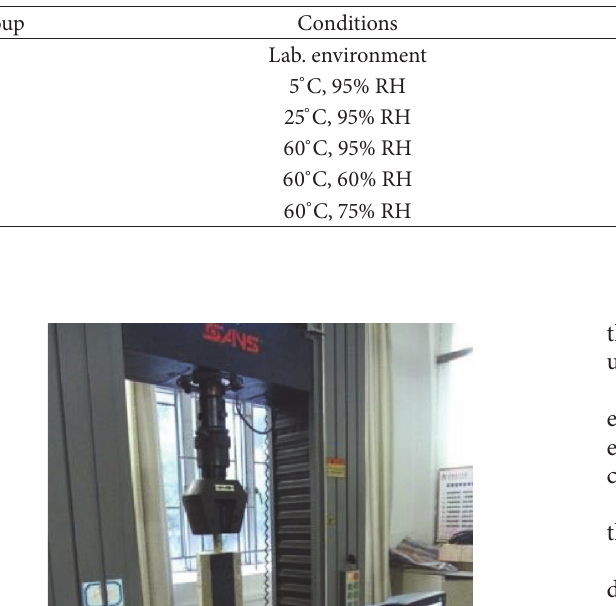
Table 3: Influence of hygrothermal environment on the ultimate load.